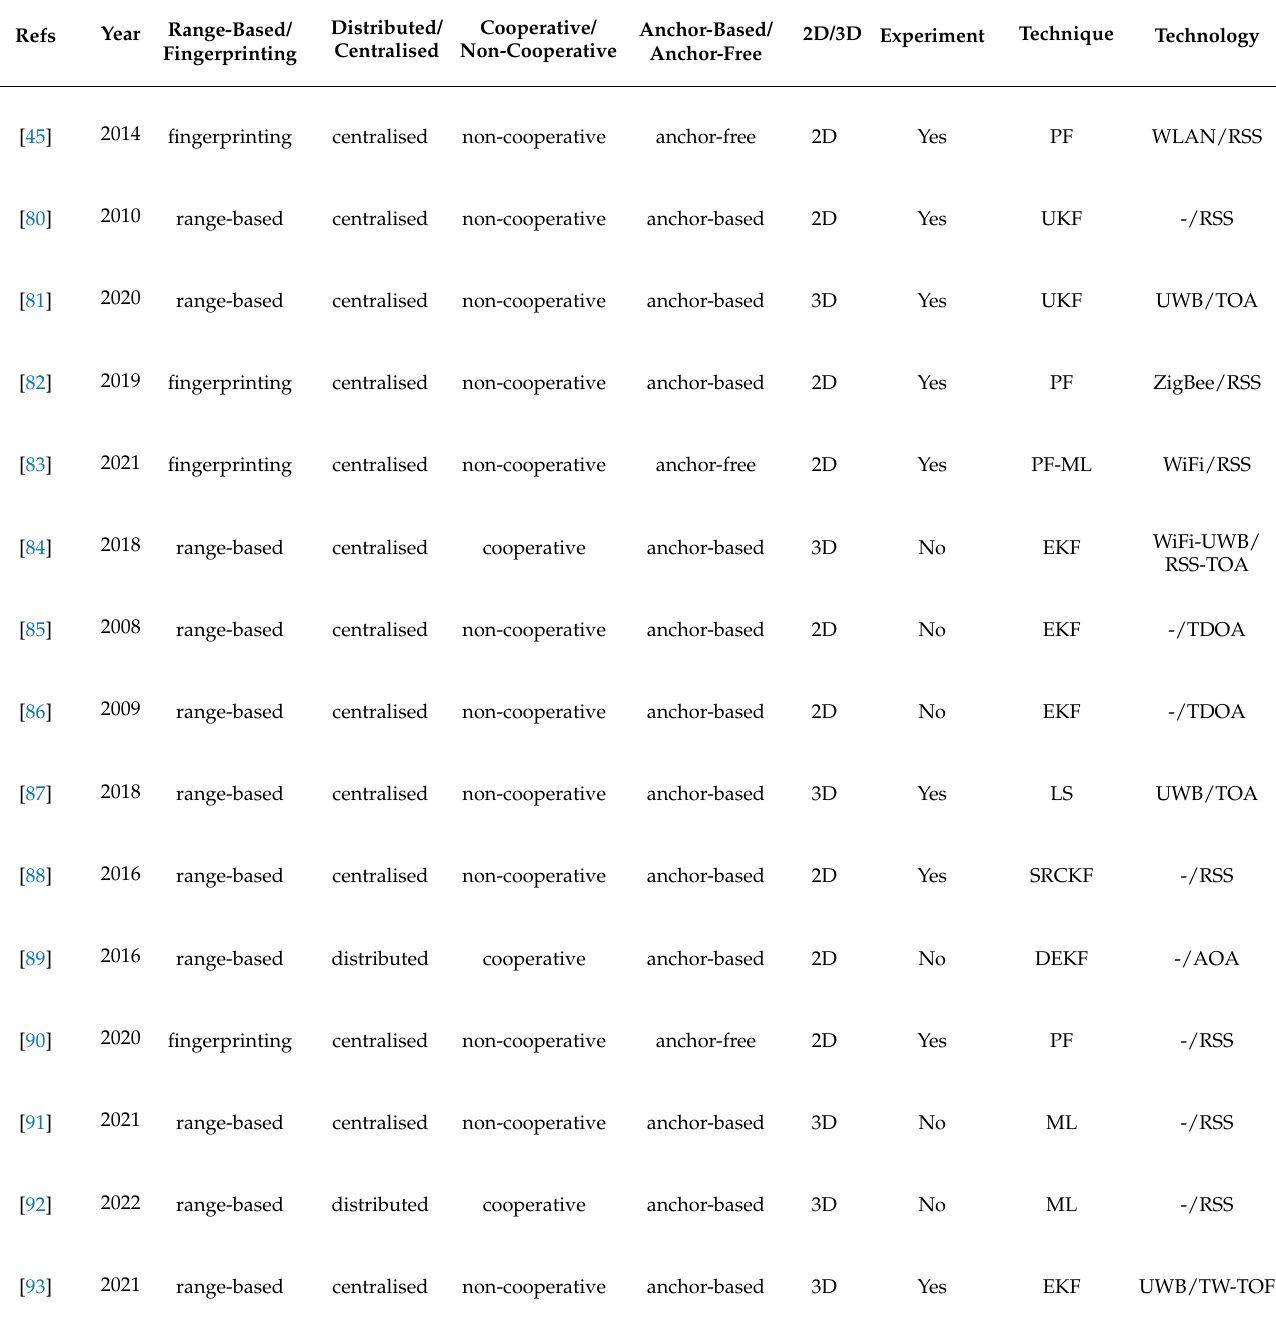
Table 3. Comparisons between existing works on RF-based localisation for UGVs and